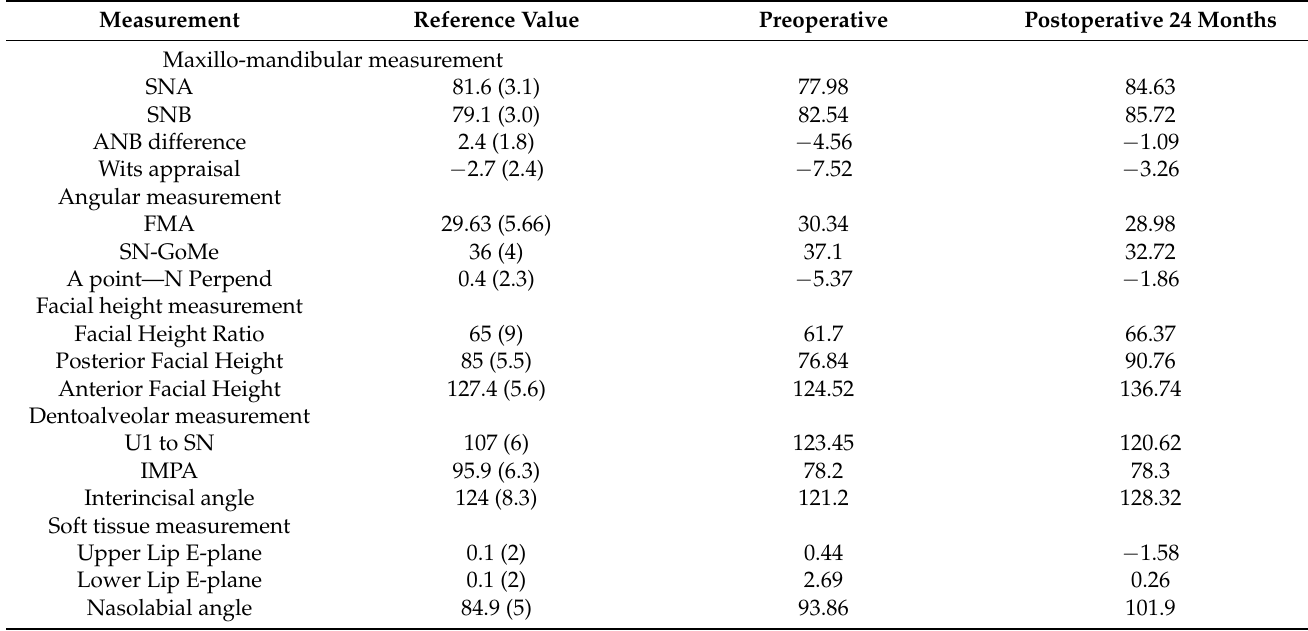
Table 1. Skeletal measurements: preoperative and postoperative (24 months) *.